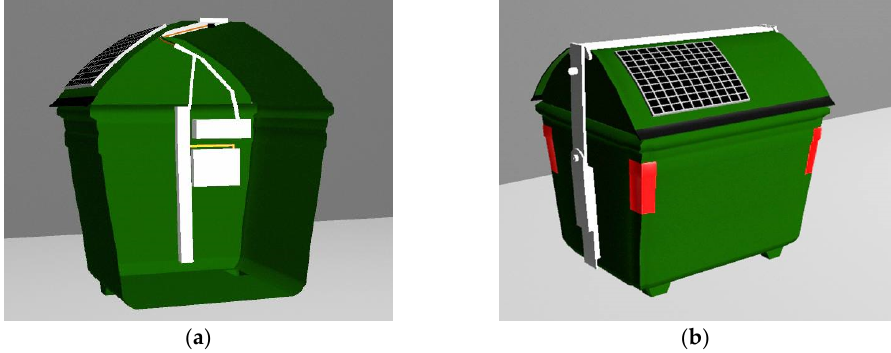
Figure 5. ( a ) Internal 3D image of module distribution. ( b ) External 3D image.